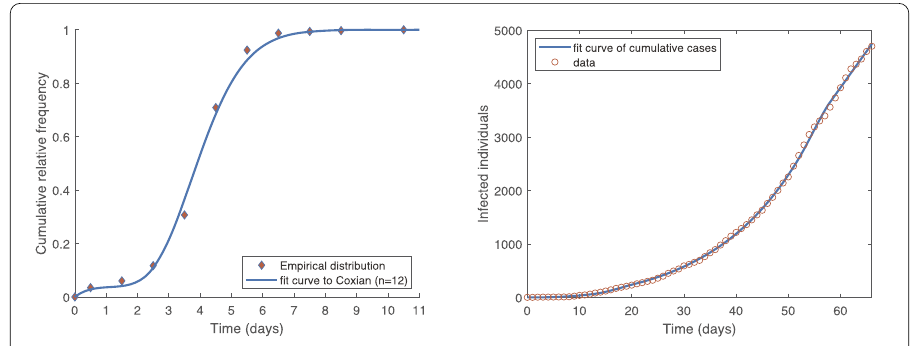
Figure 2 Results of fitting the empirical distribution of incubation period to a Coxian distribution with 12-chains (left), and to Coxian-distributed SEIR model with 12-chains (right)